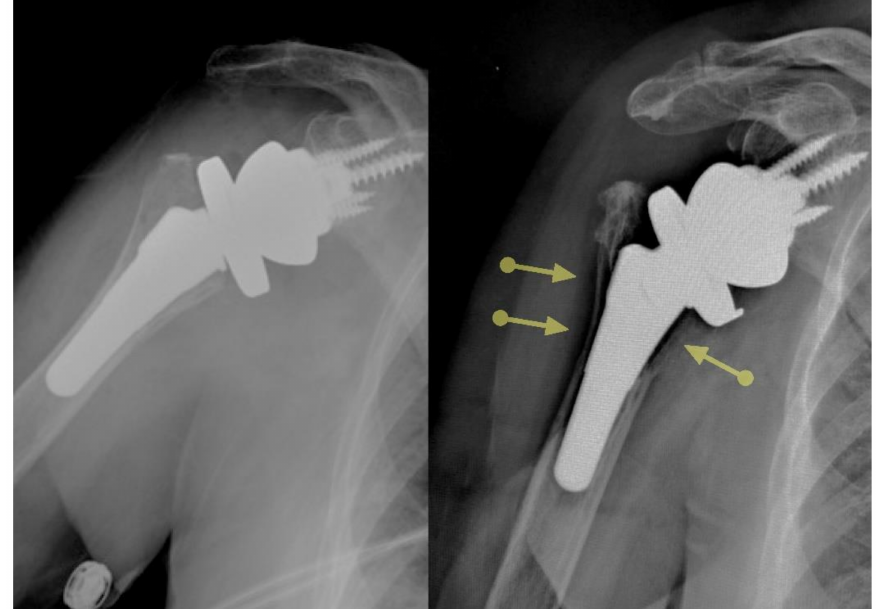
Figure 2. Certain ultrashort stems are associated with substantial stress